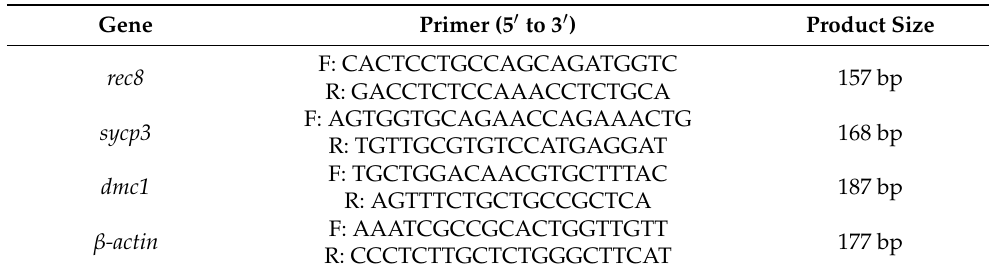
Table 2. RT-qPCR primers for examining meiotic marker genes’ expression in the testis cells of orange-spotted